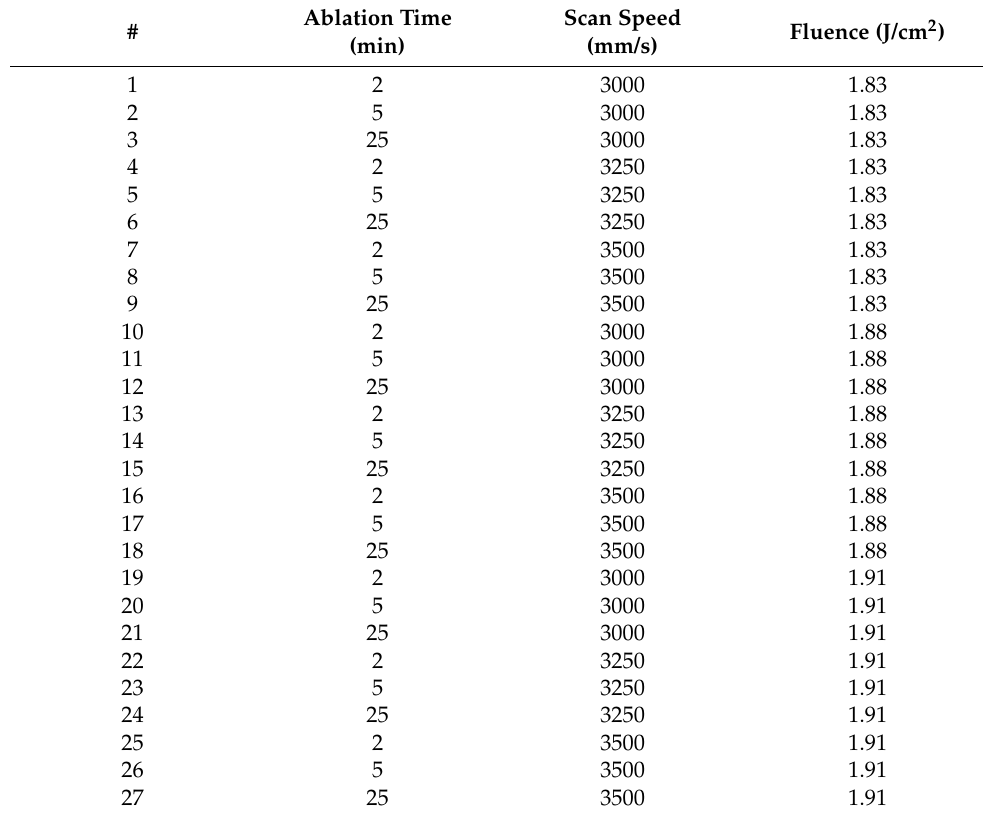
Table 1. A 3 × 3 full factorial DOE showing the laser processing parameters for each sample group (1–27). Note that 3 repeat experiments were conducted for each sample group ( n =